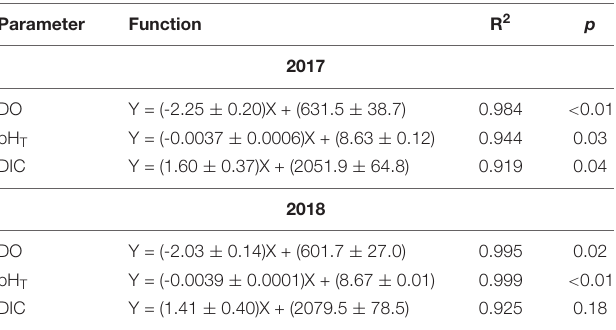
TABLE 3 | Results of linear regression of the mean DO, pH T , and DIC in bottom water against day of the year (YD) performed separately for 2017 and 2018. Parameter Function